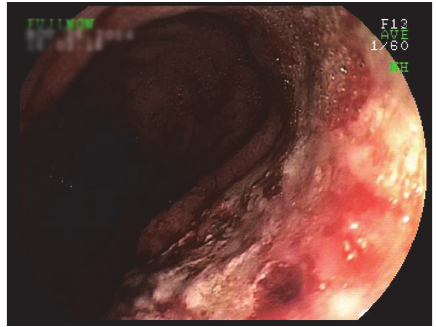
Figure 1: Esophageal ulcers on upper endoscopy.